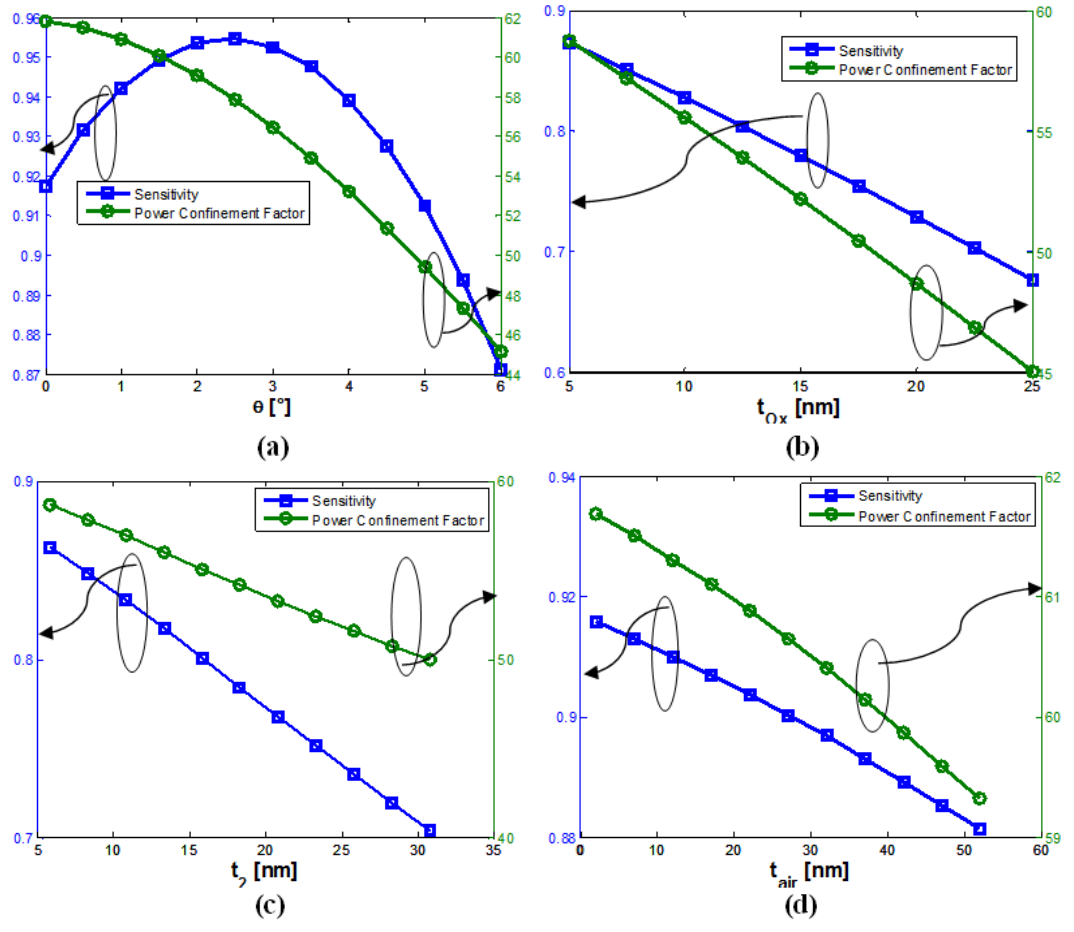
Figure 11. Sensitivity (blue curve) and Γ ( d ), for W = 155 nm, g = 120 nm and H = 400 nm. t air